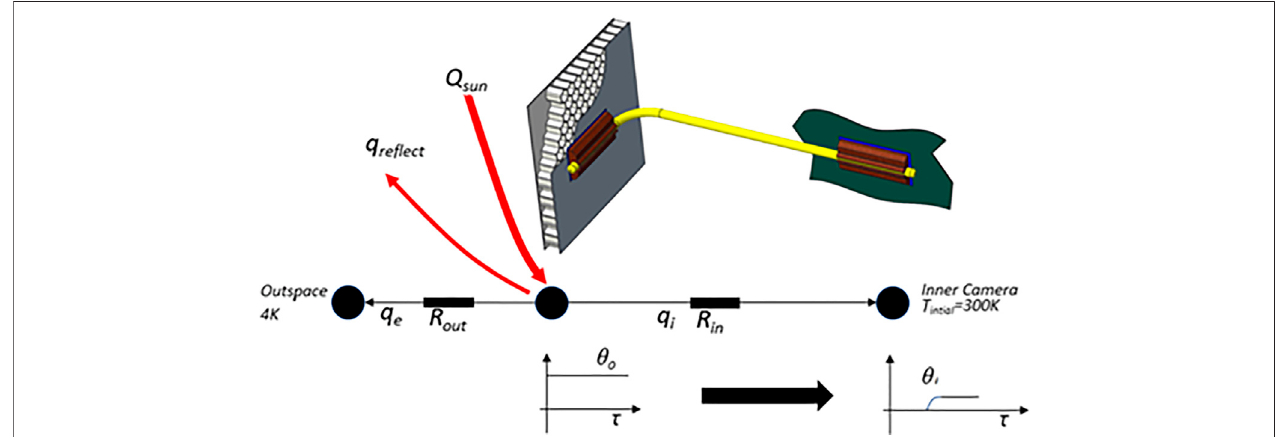
FIGURE 9 | Schematic diagram of the thermal transfer